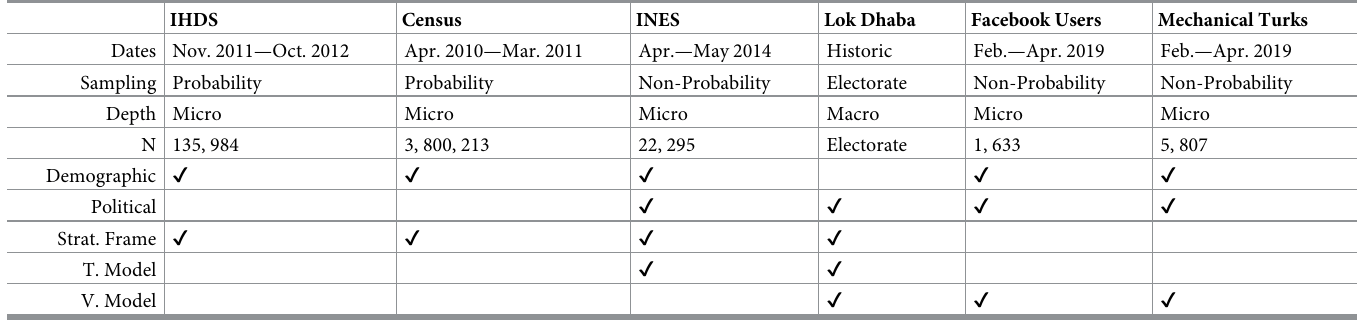
Table 1. A summary table of data sources by some meta-characteristics, including: Dates of collection; representative quality; depth; sample size; whether they include demographic or political variables; whether they are leveraged to build the stratification frame and/or the voting behaviour models. Note that though the census tables enumerate the entire population of the country at the macro-level, we sample at random from its joint distribution a smaller micro-data sample of size noted in the table, which we use later to integrate the